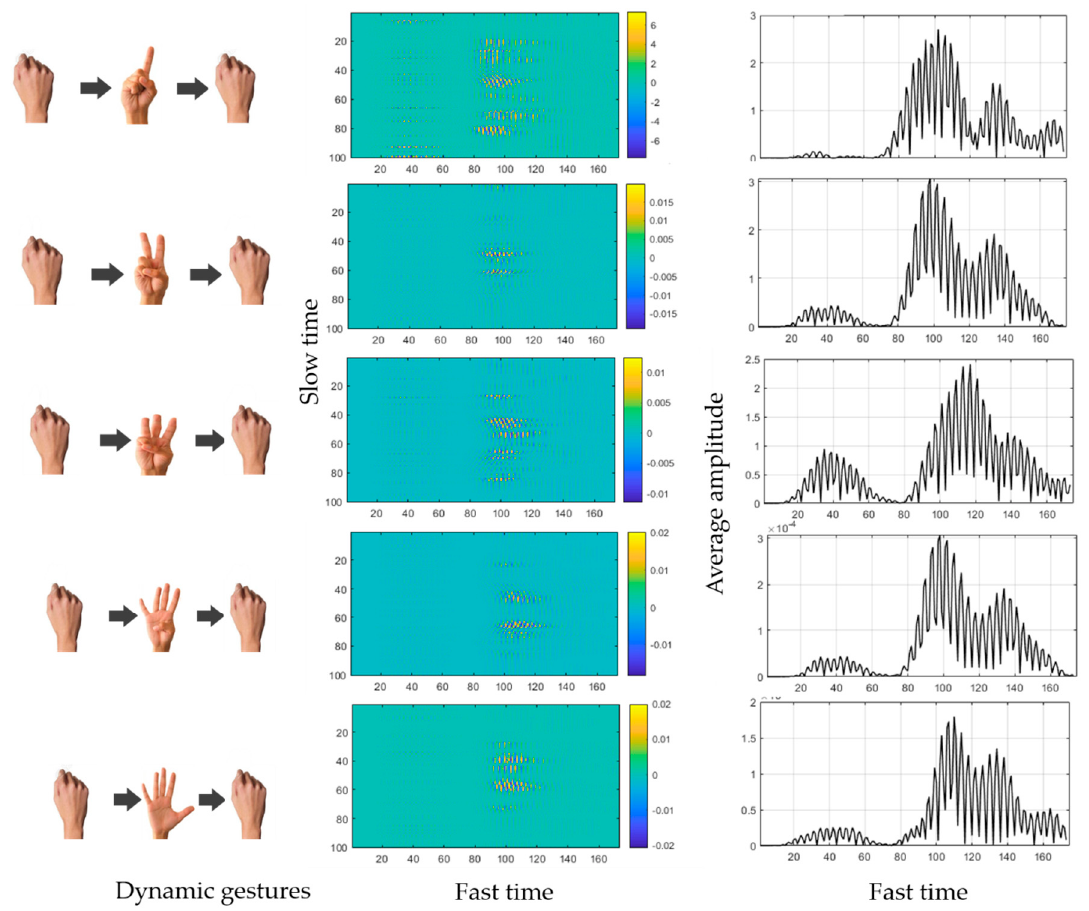
Figure 5. Dynamic gestures and corresponding generated 1 and 2-dimensional signals.